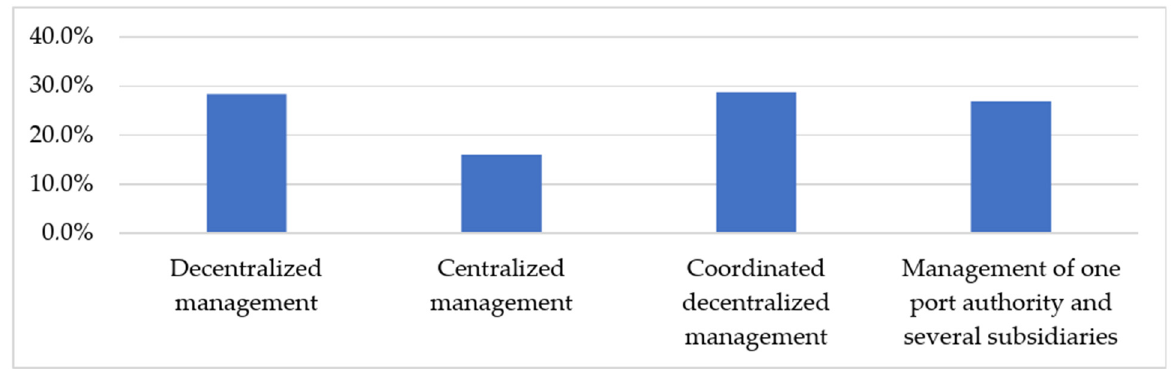
Figure 7. Graphic representation of results for the evaluated alternatives—fuzzy AHP method.